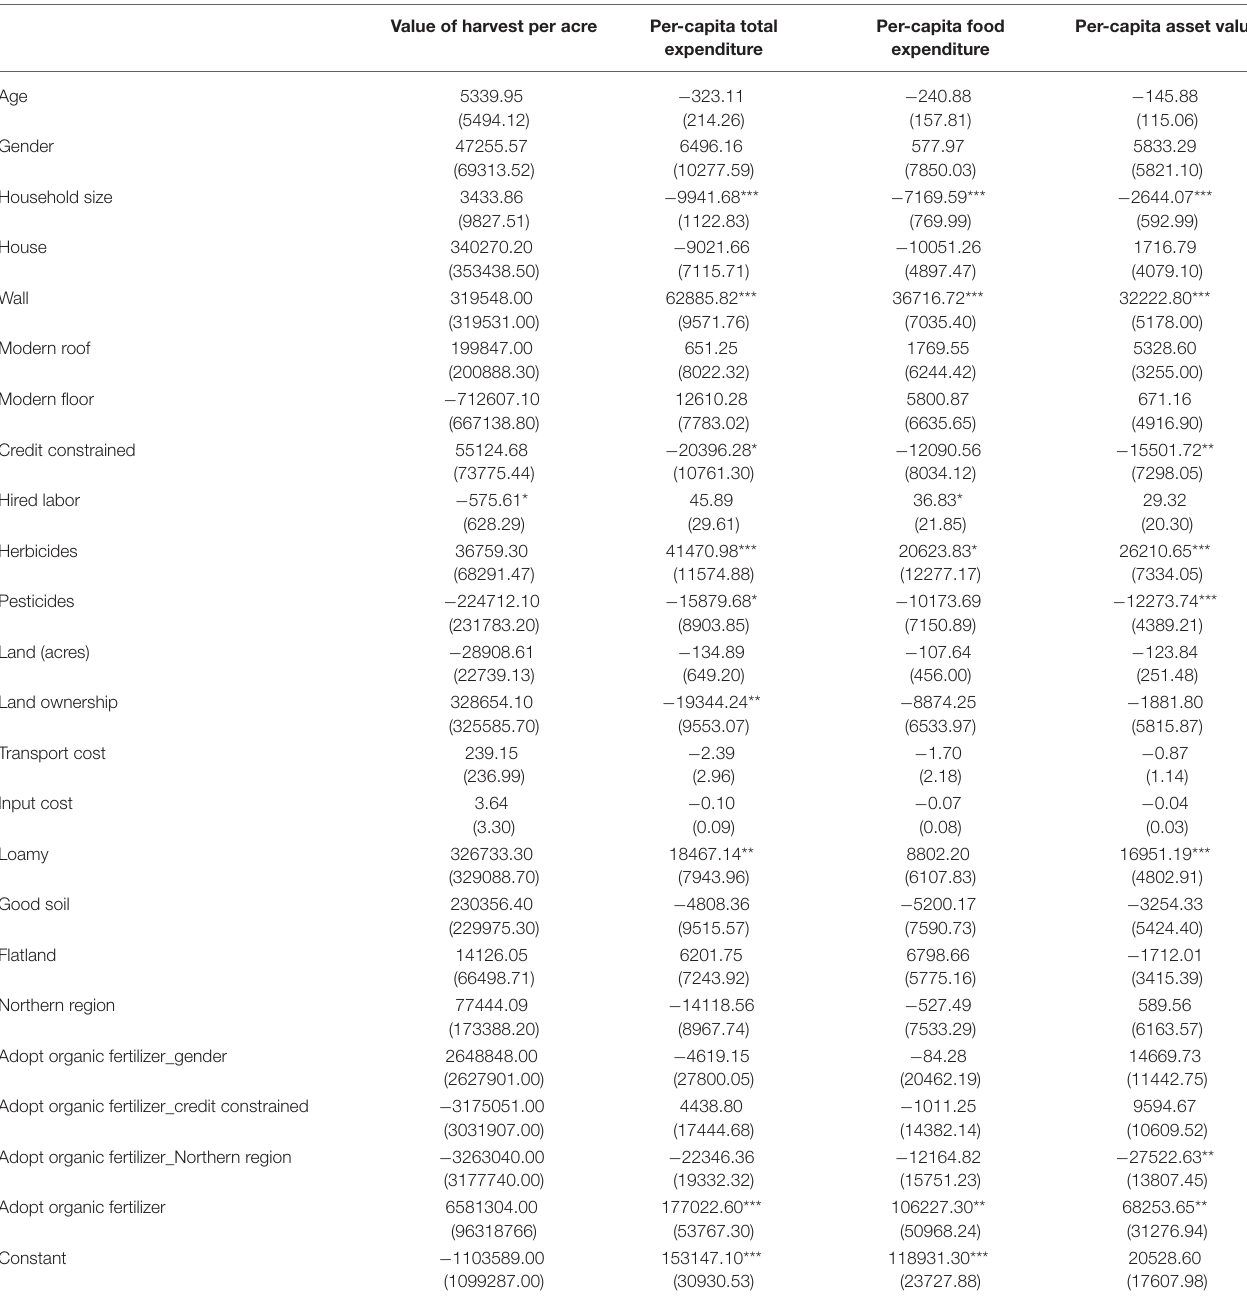
TABLE 5 | Estimates of linear endogenous treatment